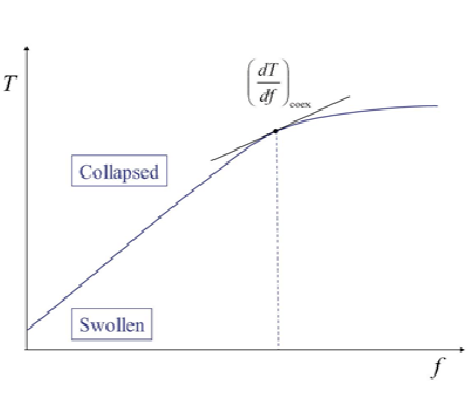
Figure 2. Schematic representation of phase diagram on the force ( f )-temperature ( T ) plane. PNIPA based polymer gels show this type of phase diagram. The curve in the figure is the phase boundary and also corresponds to the force dependence of the transition temperature.